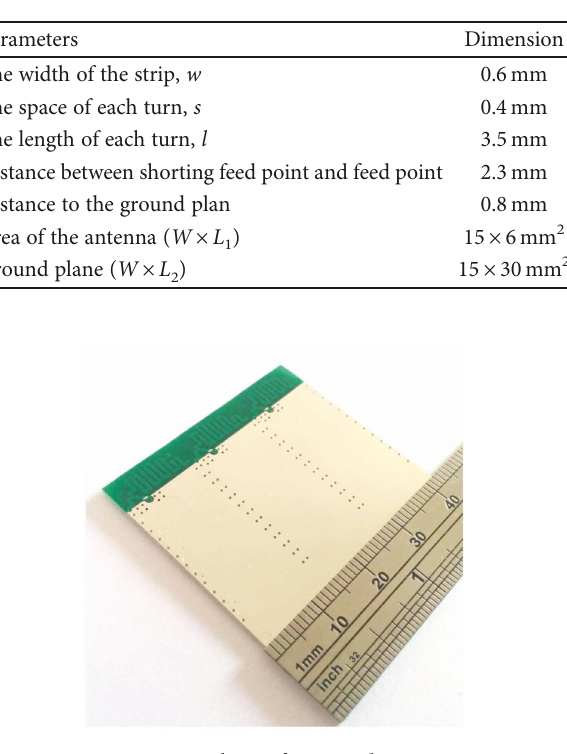
) with triangular current distribution. 2 Table 1: Parameter used in the simulation.